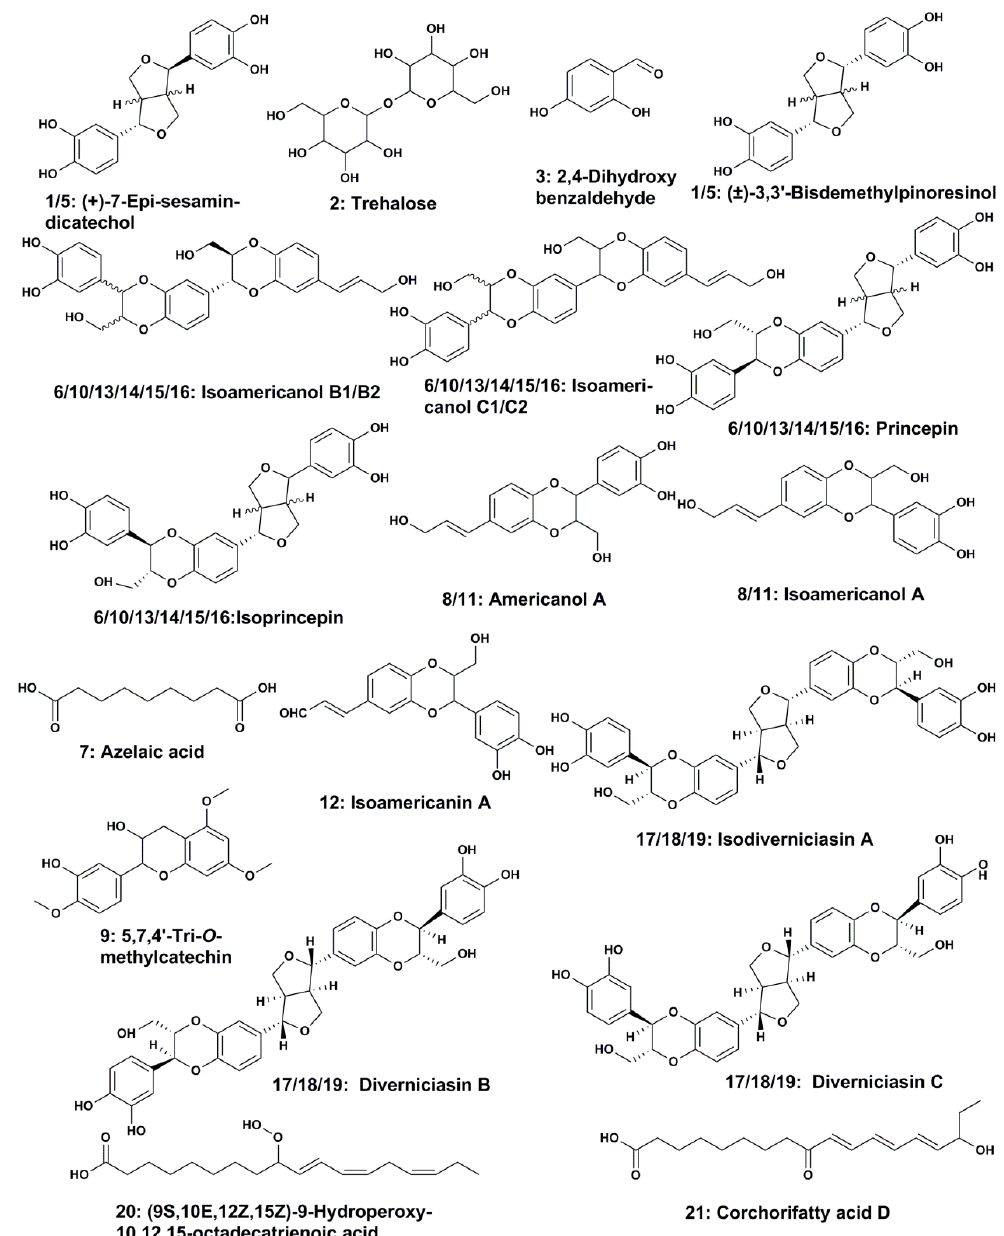
Figure 3. The structures of compounds identified from EA extracts of tung meal by UPLC-Q/TOF- MS.